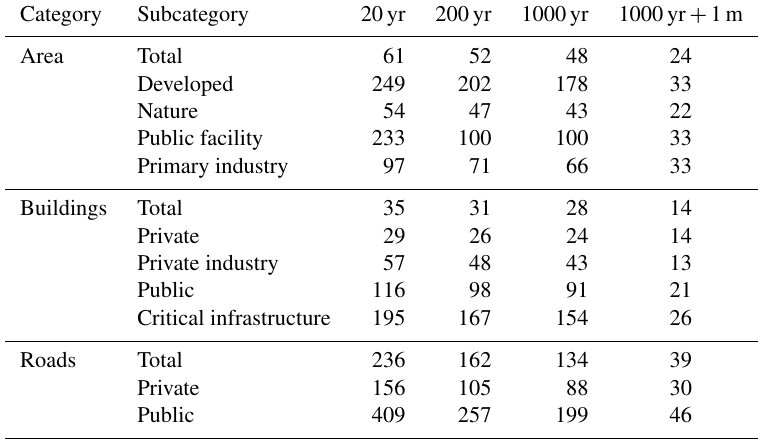
Table 5. The percentage increase in exposed areas, buildings, and roads between 2017 and 2090 for different sea level scenarios. Category Subcategory